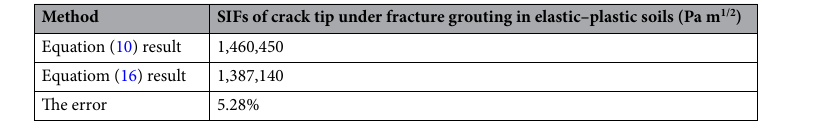
Table 2. Error value between present method and literature solution.